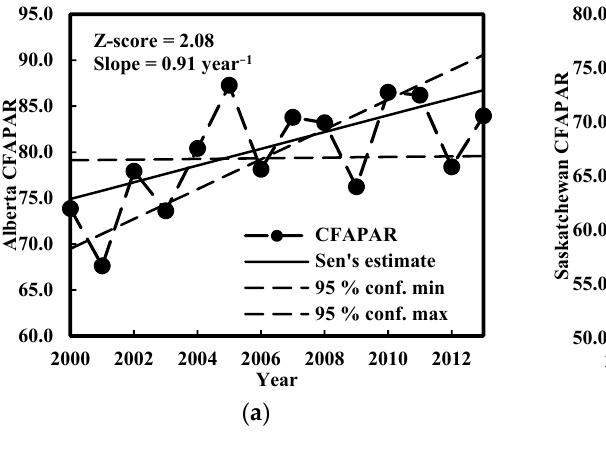
Figure 7. Cont. Figure 7. Cont.